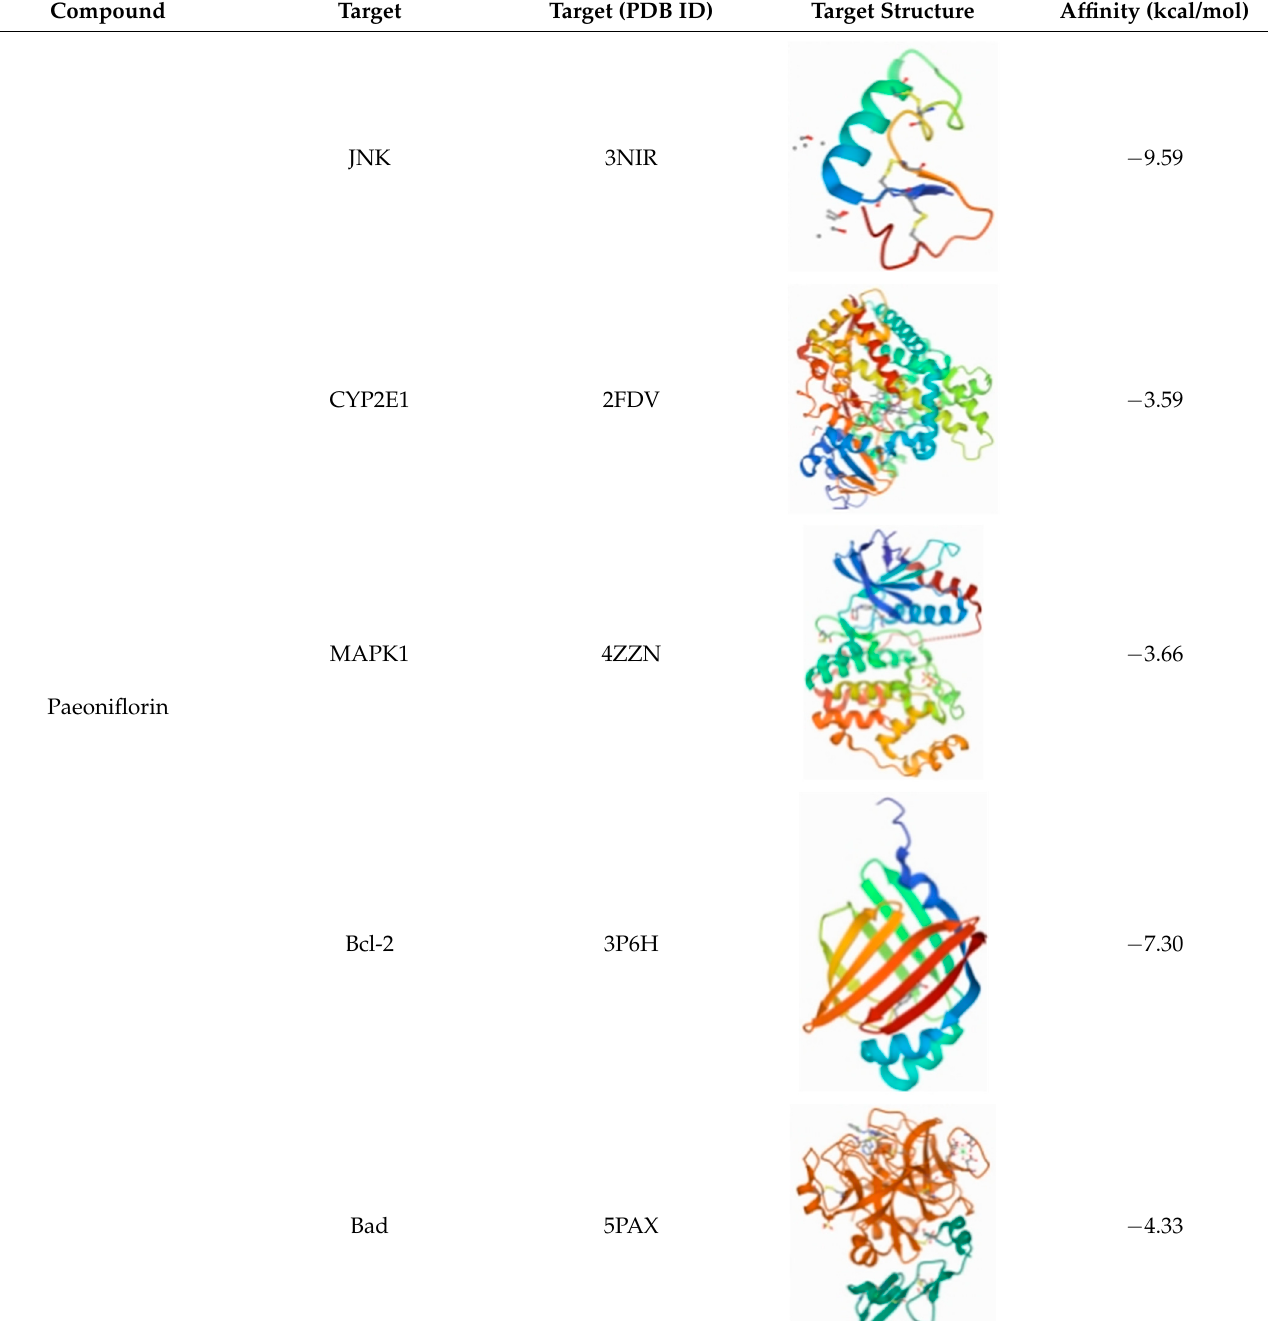
Table 2. The binding energy of PF and core targets (kcal/mol).